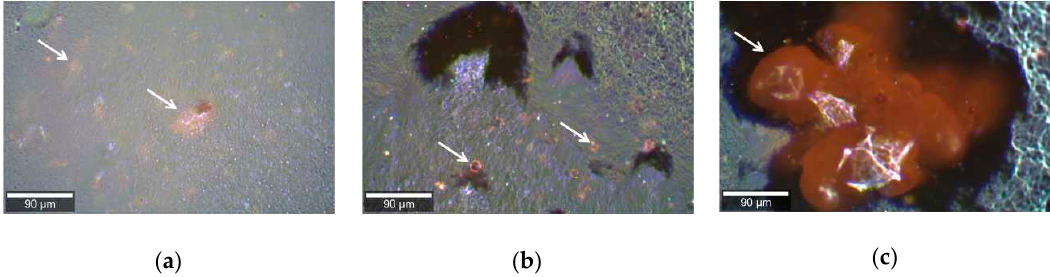
Figure 1. Micrographs of cream ( a ) and gel ( b , c ) containing curcumin, showing the presence of small aggregates of curcumin in a cream and both small ( b ) and big ( c ) ones in a gel. Fluorescence spectral and lifetime imaging measurements were performed with both formulations and show that curcumin in formulations is present both in the base and in the particles and fluorescence spectra, and that the average fluorescence lifetimes of these two forms are different. Figure 2 shows the difference in fluorescence spectra (panels a and c) and average fluorescence lifetimes (panels b and d) between the particles and curcumin distributed in the base for cream. It can be observed that curcumin fluorescence is quenched essentially in the particles (aggregates, region 2 on Figure 2a) and fluorescence emission spectrum of the aggregates is red-shifted comparing to the spectrum of the curcumin distributed in the base of the cream (region 1 on Figure 2a).